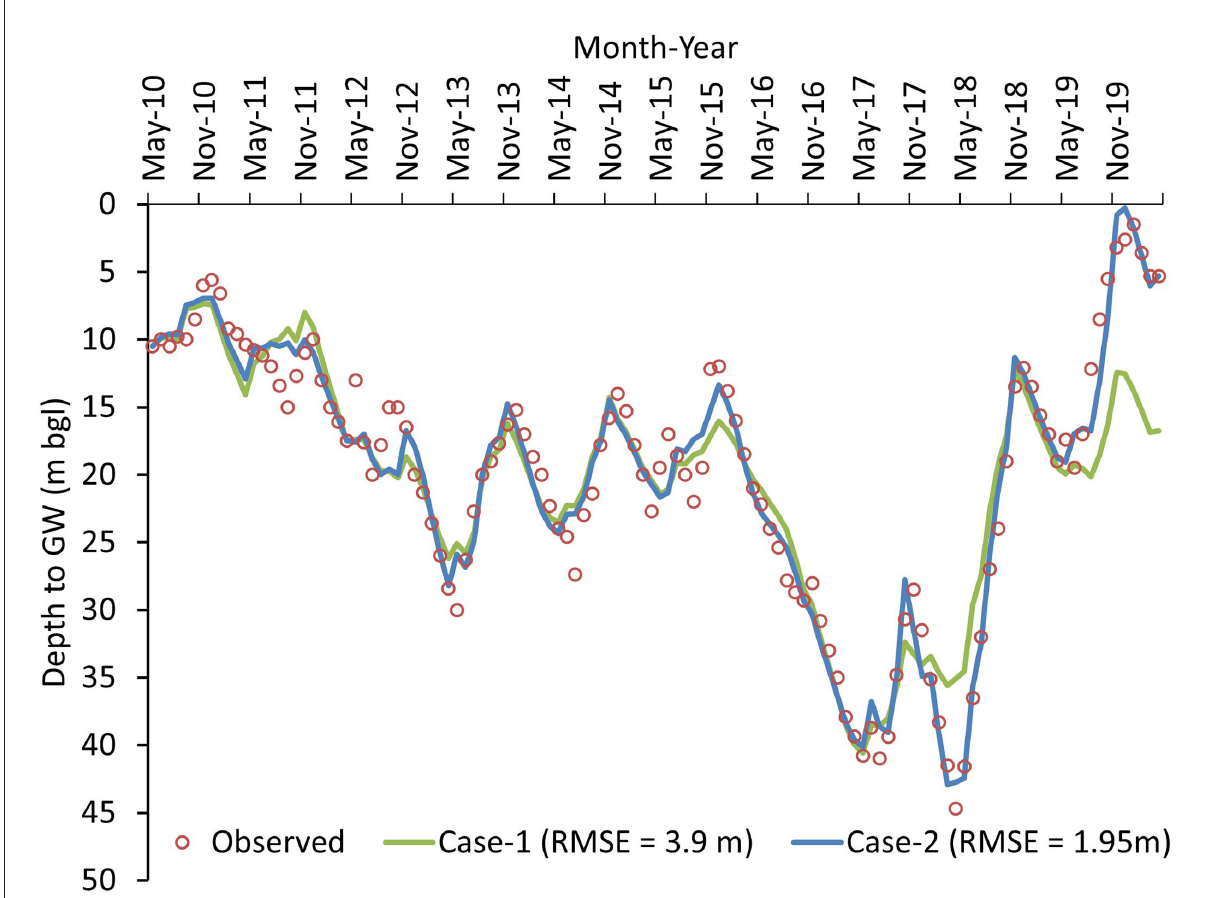
FIGURE8 Comparison of simulated groundwater levels with considering constant recharge factor (Case-1) vs. high-episodic recharge factor